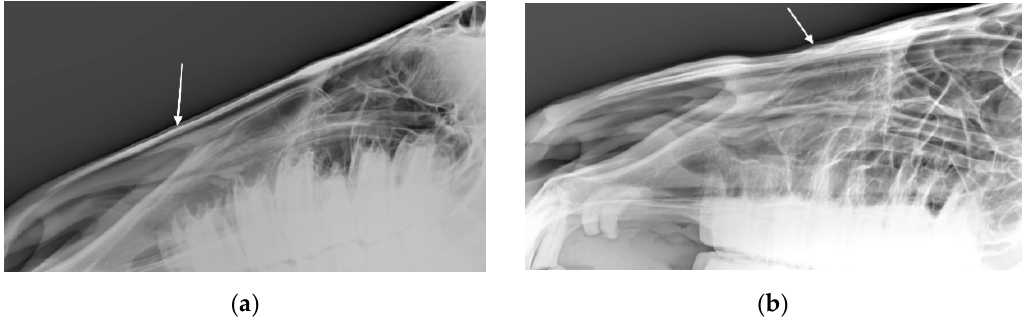
Figure 4. Radiographs showing the nasal bones of a horse in which radiologists ( n = 2) agreed there was bone deposition that was: ( a ) typical of affected horses and ( b ) moderate. Animals 2020 , 10 , x FOR PEER REVIEW